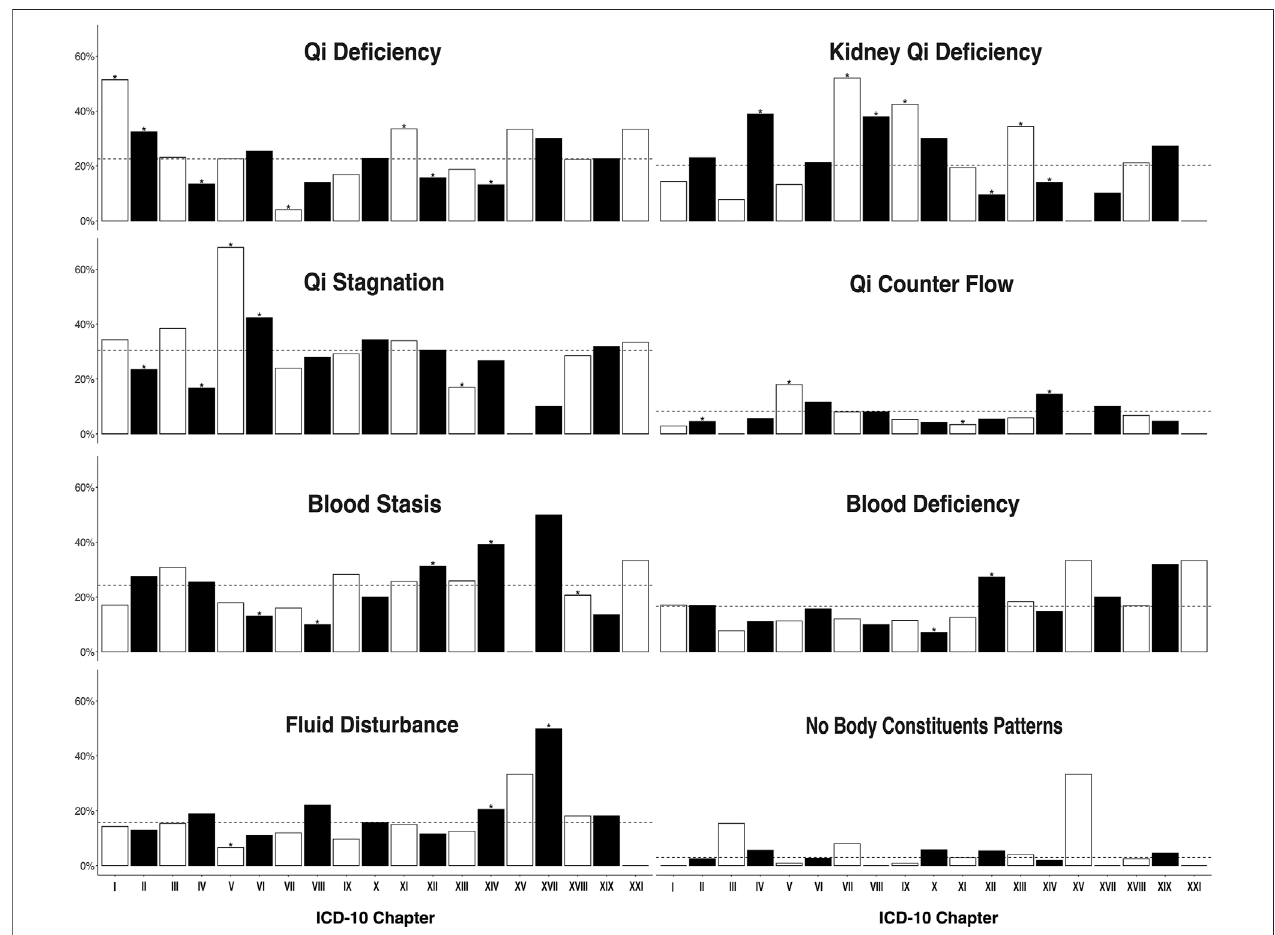
FIGURE3| Proportionofparticipantswithbodyconstituentspatternineachthe10thversionoftheInternationalClassi fi cationofDiseaseschapters.* p < 0.05ICD (cid:1) International Classi fi cation of Diseases. The facet of fl uid de fi ciency is hidden due to its limited participant number ( n (cid:1) 4). I: Infection (35); II: Neoplasm (200); III: Hemotology/Immunology (13); IV: Endocrine/metabolism (90); V: Psychiatry (106); VI: Neurology (146); VII: Ophthalmology (25); VIII:Audiology (50); IX: Circulatology (113); X: Pulmonology (70); XI: Gastroenterology (206); XII: Dermatology (147); XIII: Musculoskeletal (224); XIV: Genitourology (243); XV: Obstetrics (3); XVII: Congenital (10); XVIII: Symptoms/signs (474); XIX: Injury/poisoning (22); XXI: Health state